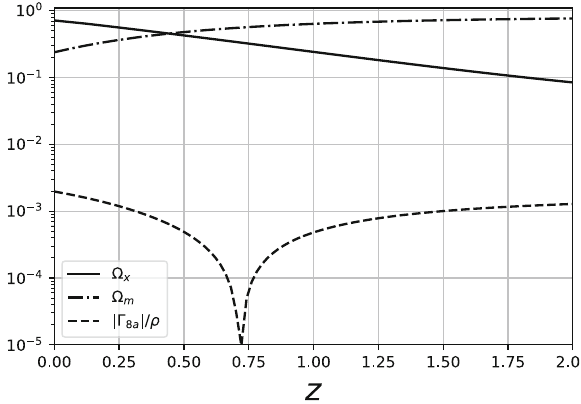
Fig. 4 Semilog graphic of the evolution of the density parameters for the interacting model (cid:8) 8 a , note that the interaction has a sign change at redshift z ≈ 0 . 7